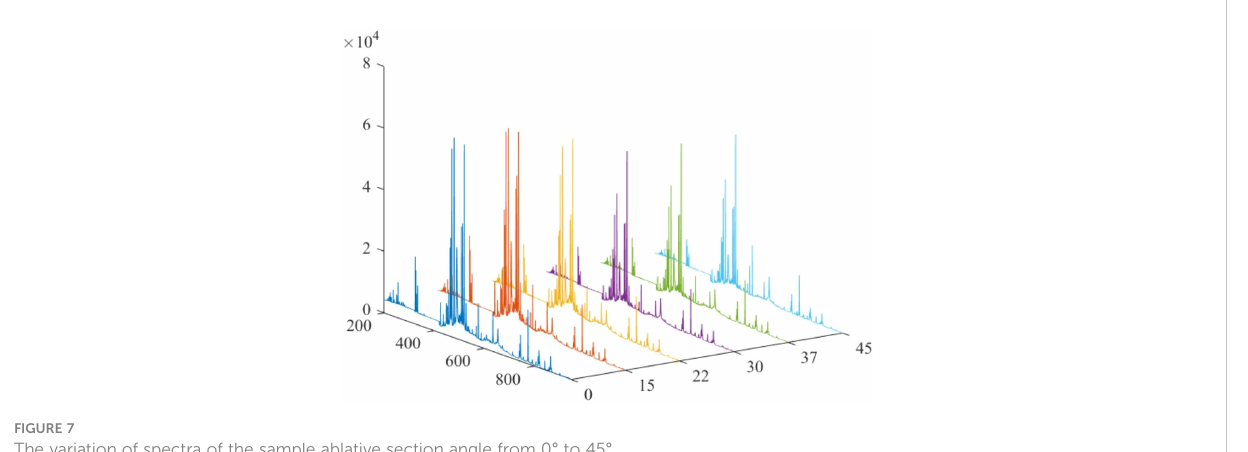
FIGURE 7 The variation of spectra of the sample ablative section angle from 0° to